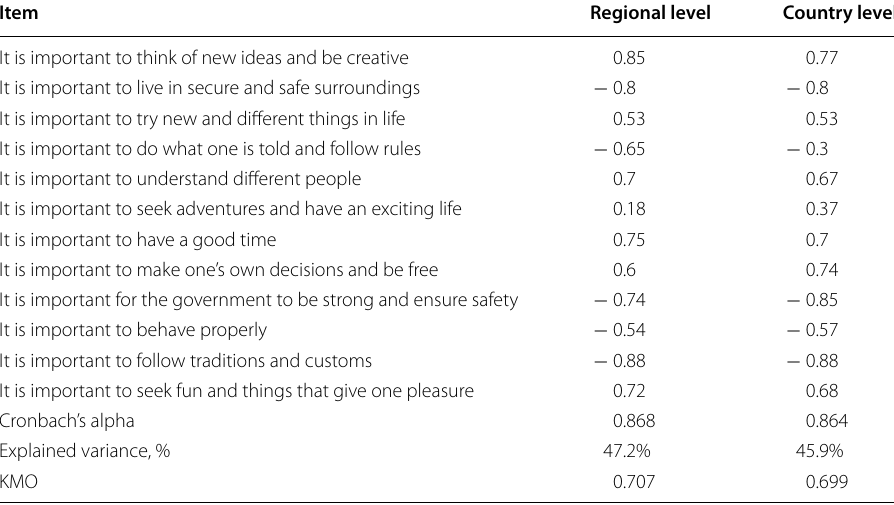
Source: calculated from European Social Survey data